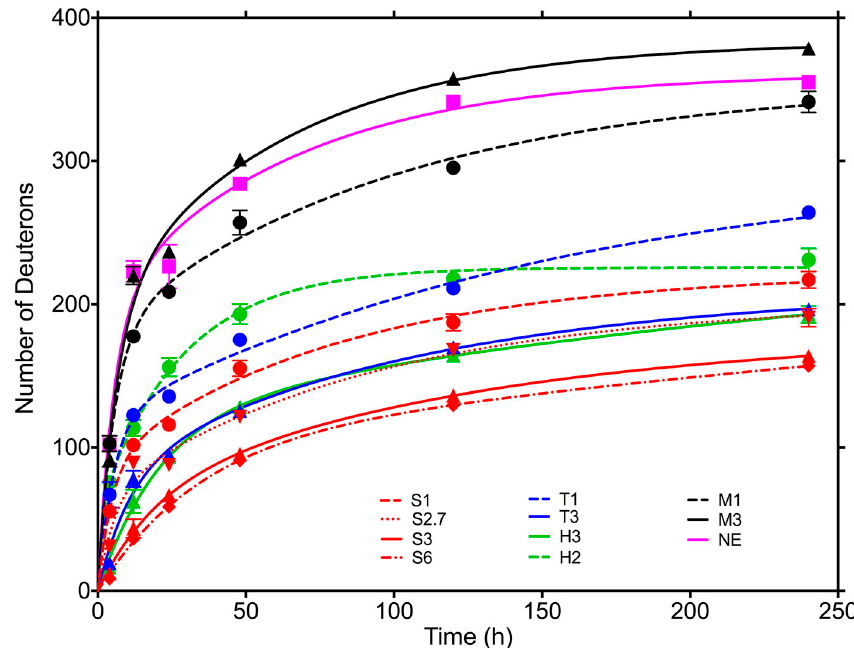
Figure 14. Time dependence of deuterium exchange for lyophilized monoclonal antibody in several different formulations (exposure to D 2 O vapor at 11% RH and 22 °C). Formulations: M3, mannitol 3:1; M1, mannitol 1:1; S6, sucrose 6:1; S3, sucrose 3:1; S2.7, sucrose 2.7:1; S1, sucrose 1:1; T3, trehalose 3:1; T1, trehalose 1:1; H3, histidine 3:1; H2, histidine 2:1; NE (no-excipient), without excipient. Ratios represent excipient/antibody w/w ratio. Reproduced with permission from [137], ACS, 2018.